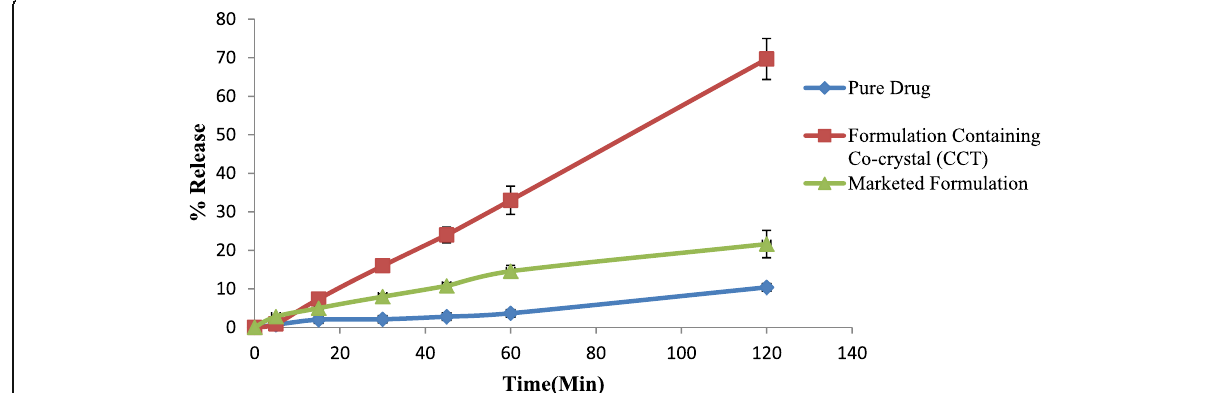
Fig. 9 Dissolution profile of pure drug (blue line), formulation containing co-crystal (CCT) (red line) and marketed formulation (green line) ( n = 3, mean ± SD)